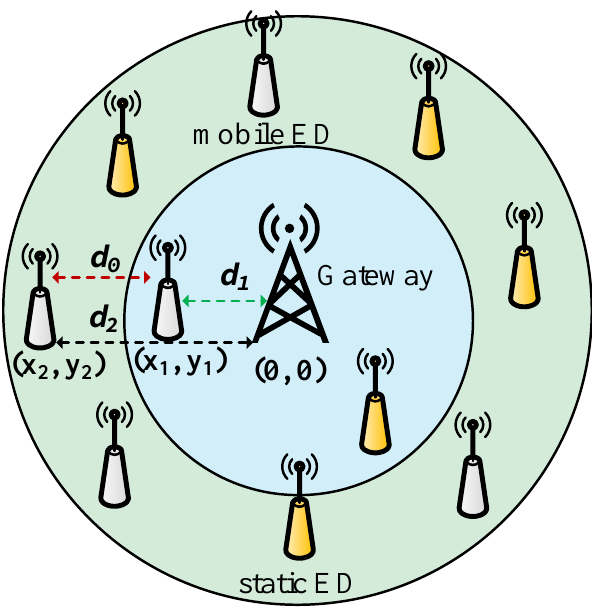
Figure 5. Distance between current and previous positions of the end device.